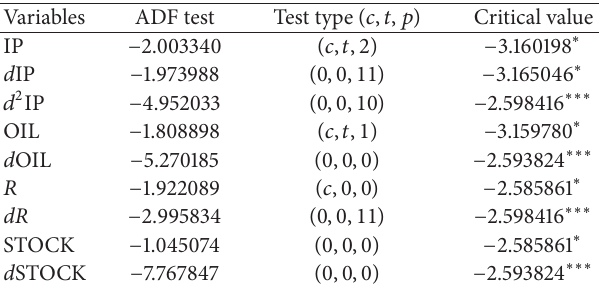
Table 1: The test result of unit root. Table 2: The choose of lag orders in the